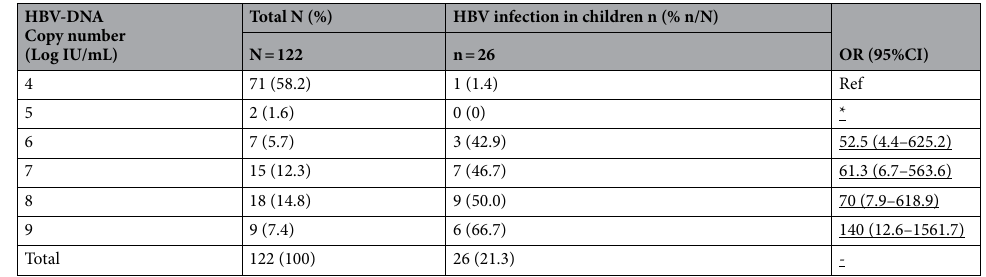
Table 2. Association of HBV infection in children with HBV DNA copy number in mothers in the 2-year follow-up phase, Nha Trang, Vietnam, 2011–2012 (N = 122). Logistic regression was used for projecting odds ratios (OR) in univariate analysis. Variables with statistical significance were underlined when 95%CI of OR did not include 1. *Omitted due to lack of samples for analysis. HBV: hepatitis B virus; DNA: deoxyribonucleic acid; HBsAg: hepatitis B surface antigen; N: number; OR: odds ratio; CI: confidence interval; and Ref.: